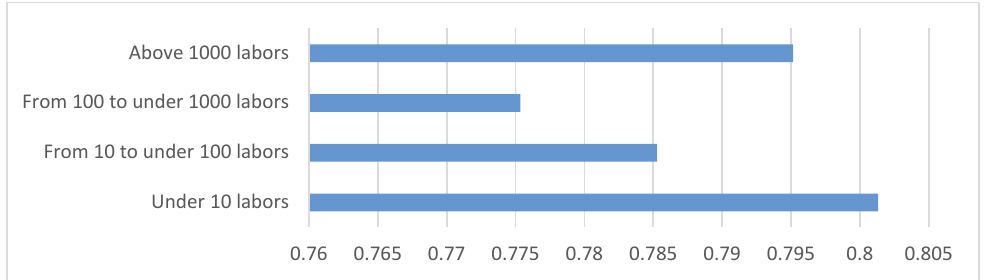
Fig. 3. Efficiency score by labor size